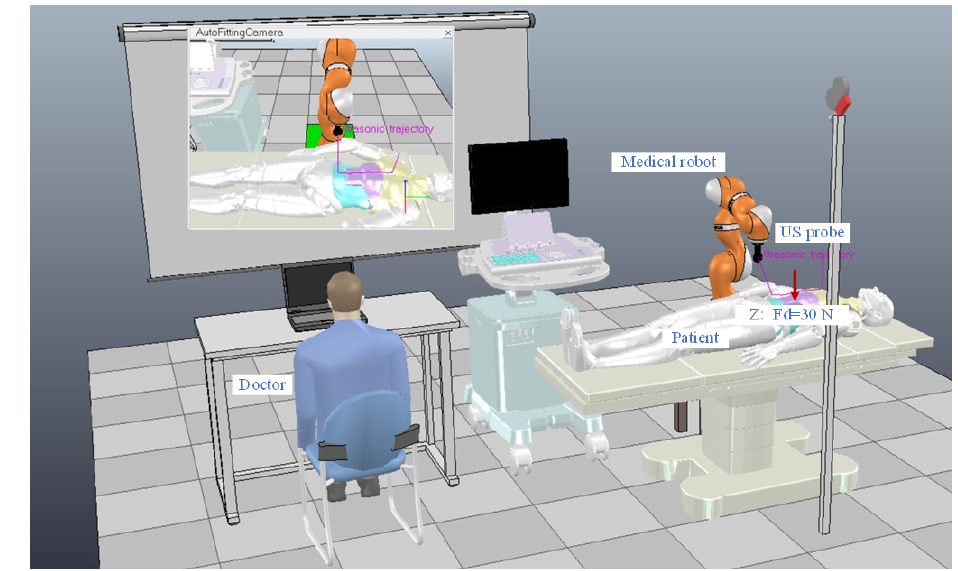
Figure 11. The V-rep set-up for the ultrasound robot abdominal ultrasonography. A KUKA light-weight robot (LWR) is utilized to conduct the scan of the patient’s abdomen in a more realistic